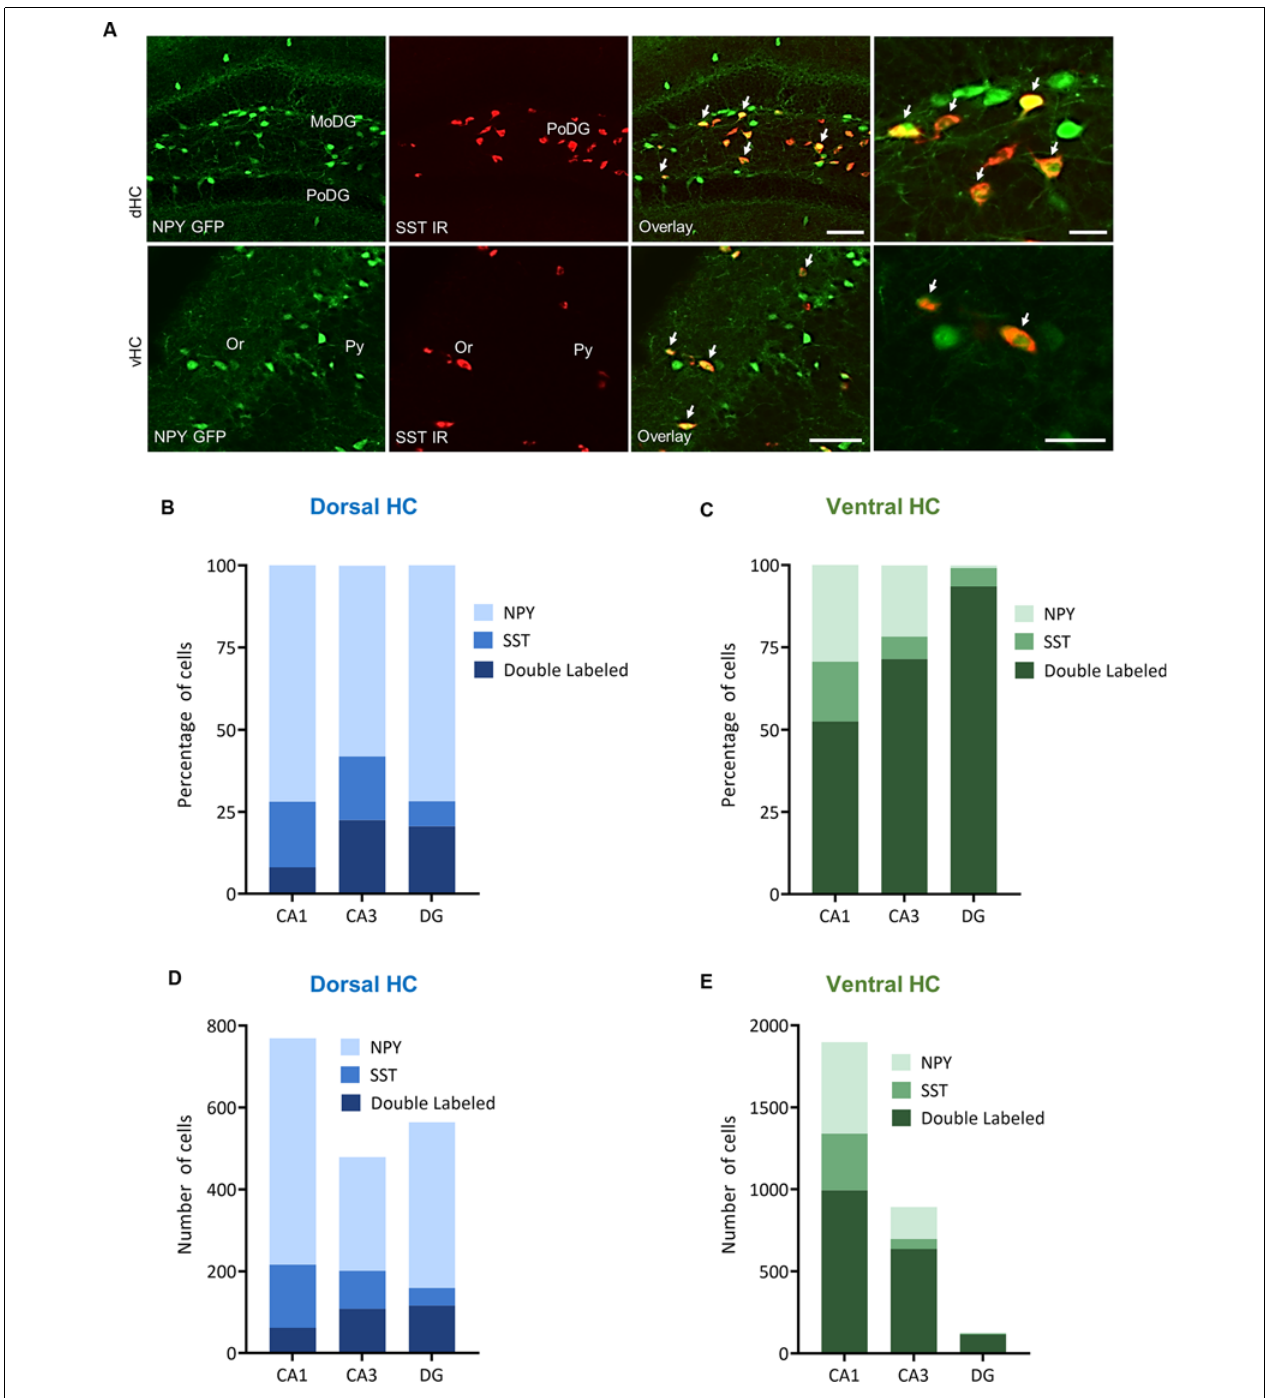
FIGURE 6 | Distribution and quantification of co-expression of somatostatin (SST) with NPY in the dorsal (dHC) and ventral (vHC) mouse hippocampus. (A) Dual immunohistochemistry for SST and NPY-GFP auto-fluorescence in the dorsal (dHC) and ventral hippocampus (vHC) of NPY-GFP mice. Cells in green indicate NPY-GFP + neurons and cells in red indicate SST expressing neurons. (B) Histograms showing the percentage of NPY-GFP neurons in CA1, CA3, and DG of the dorsal hippocampus that are co-labeling with SST. (C) Histograms showing the percentage of NPY-GFP neurons in CA1, CA3, and DG of the ventral hippocampus that are co-labeling with SST. In the ventral hippocampus a very high proportion of NPY neurons co-express SST. (D) Number of NPY-GFP and SST neurons in CA1, CA3, and DG of the dorsal and (E) ventral hippocampus. Scale bars: lower magnification 200 µ m (third column), higher magnification 50 µ m (last column). Abbreviations: MoDG, molecular layer of the dentate gyrus; PoDG, hilus/polymorph layer of the dentate gyrus; SGZ, subgranular zone; Or, stratum oriens; Py, stratum pyramidale.